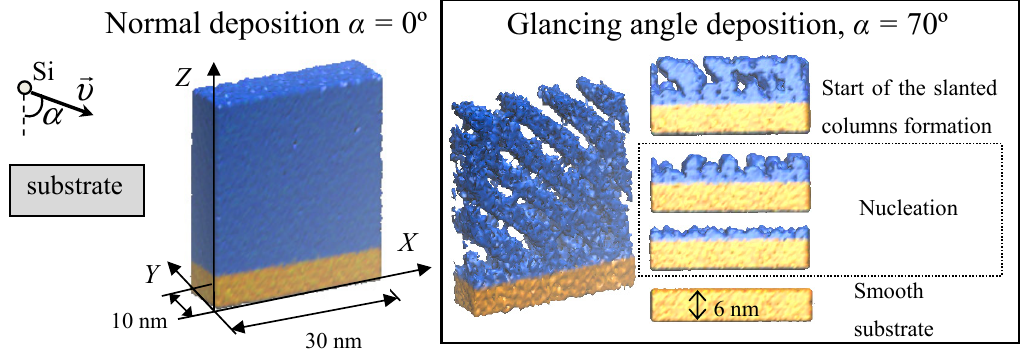
Figure 2. Structure of normally deposited and glancing angle deposited films.